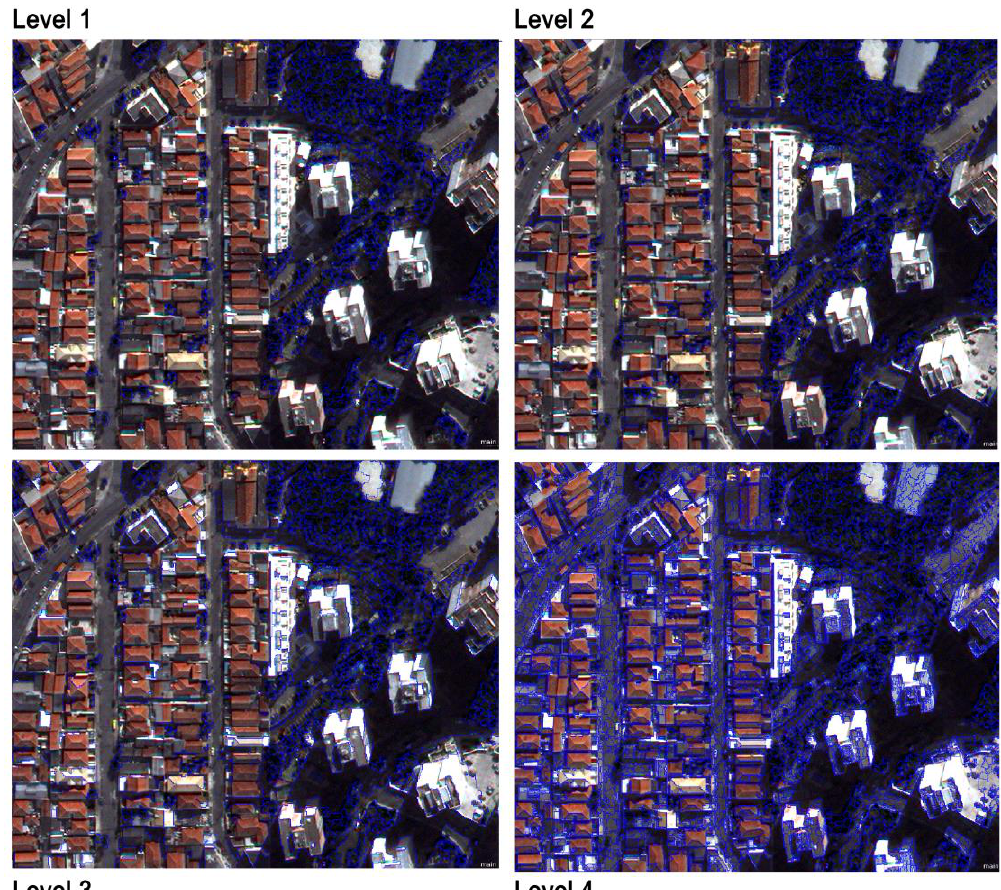
Figure 3. Multiresolution segmentation